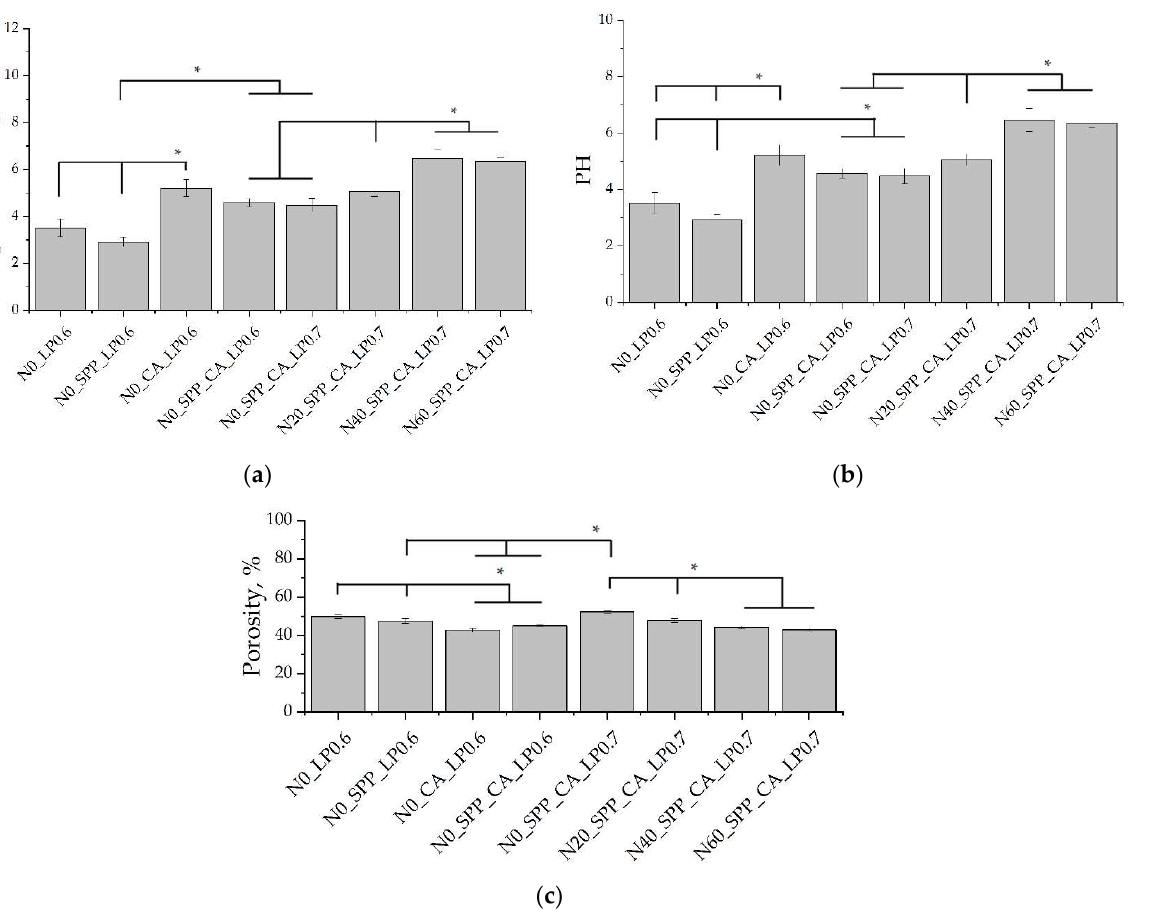
Figure 6. The characteristics of ceramics: ( a ) compressive strength; ( b ) pH; ( c ) porosity. Significant differences are labeled with * ( p < 0.05).